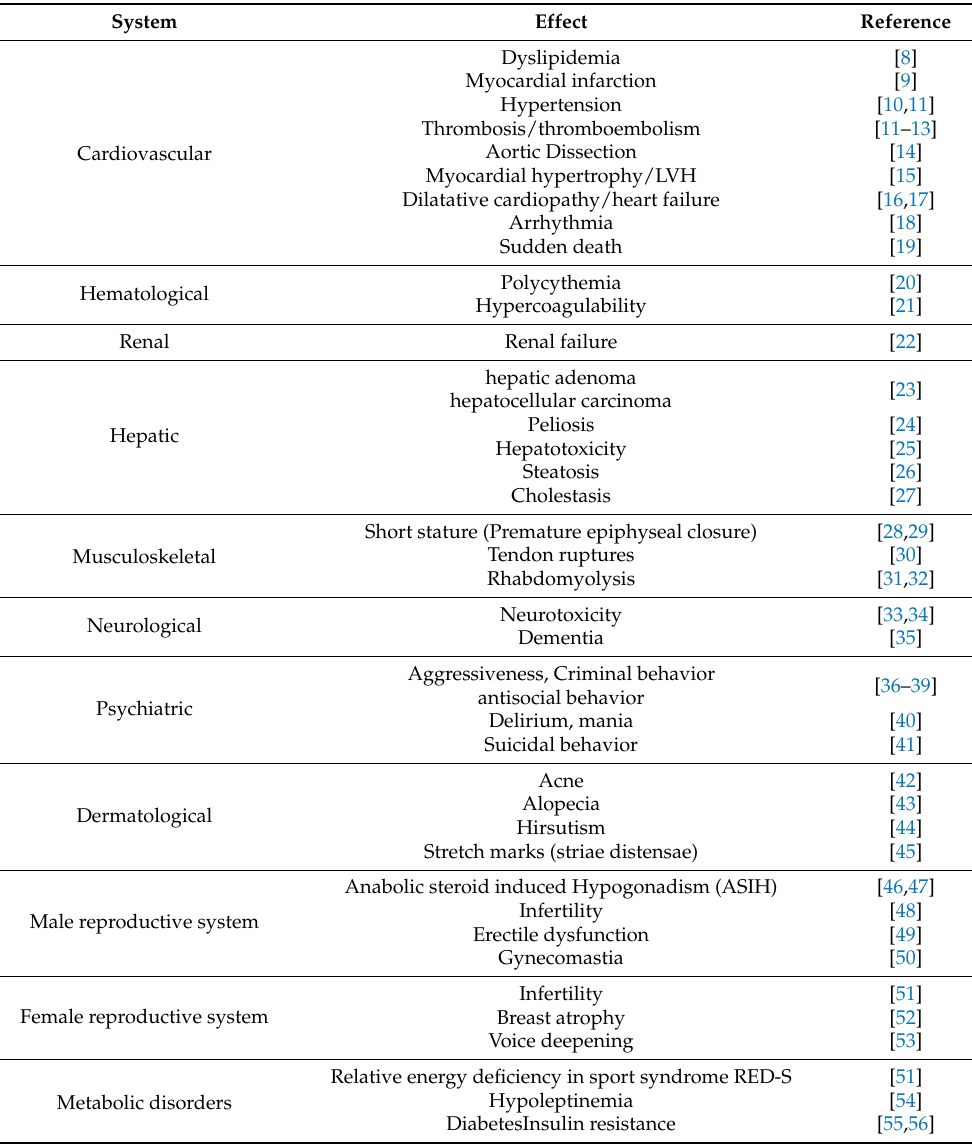
Table 3. Negative effects of steroid consumption on different